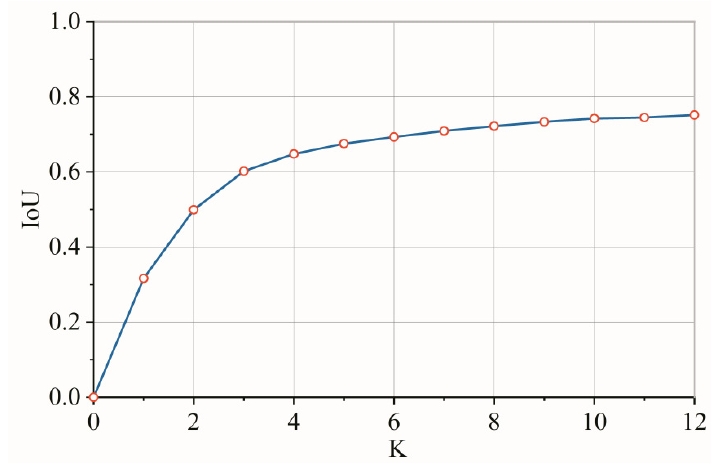
Figure 9. Average IoU varying with the number of anchor boxes. Table 2. Correspondence between anchor boxes and feature maps.